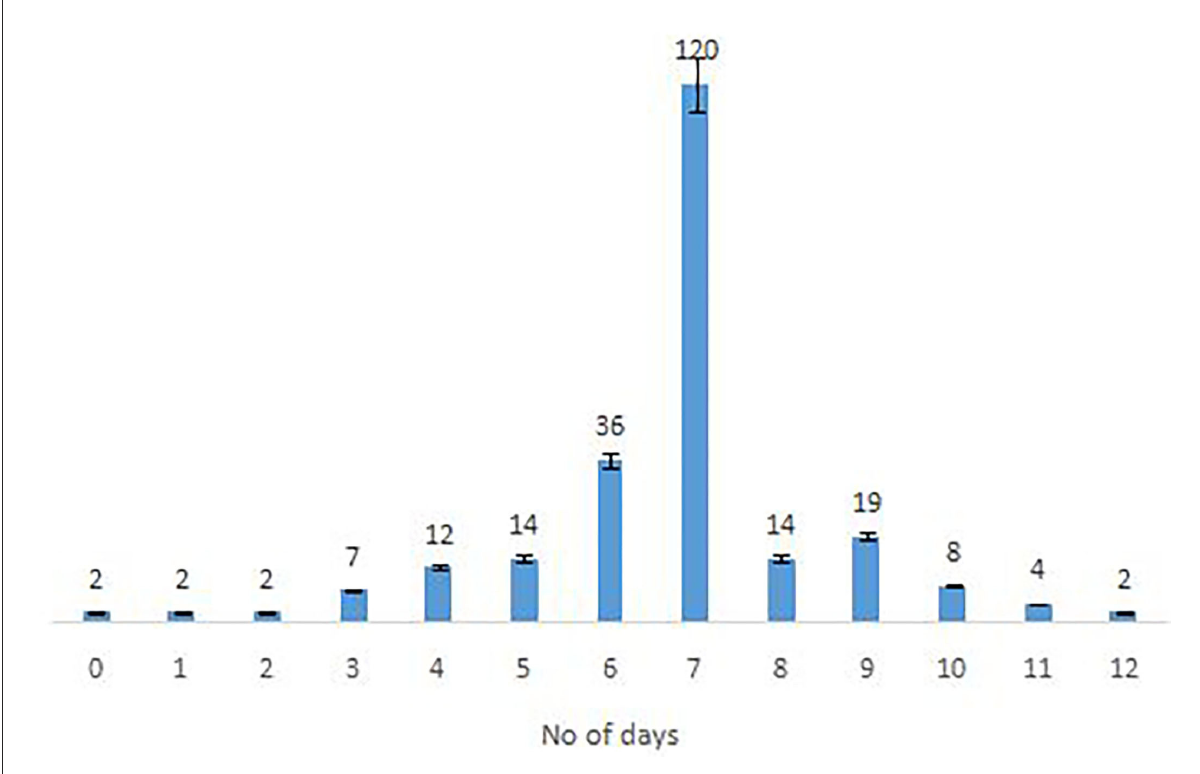
FIGURE2 Time to recovery after PCR positivity in Omicron cases.